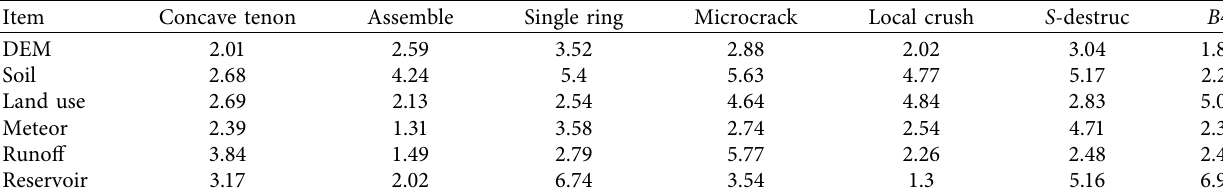
Table 5: The effective stiffness of staggered joint